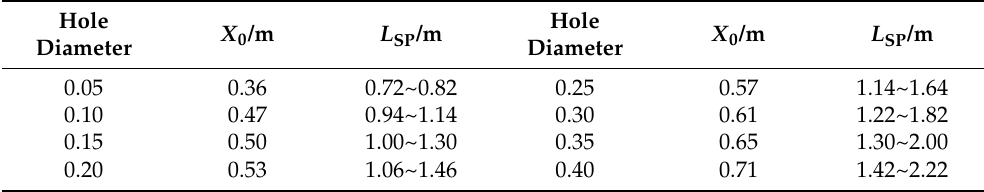
Table 2. Reasonable borehole spacing under each hole diameter.